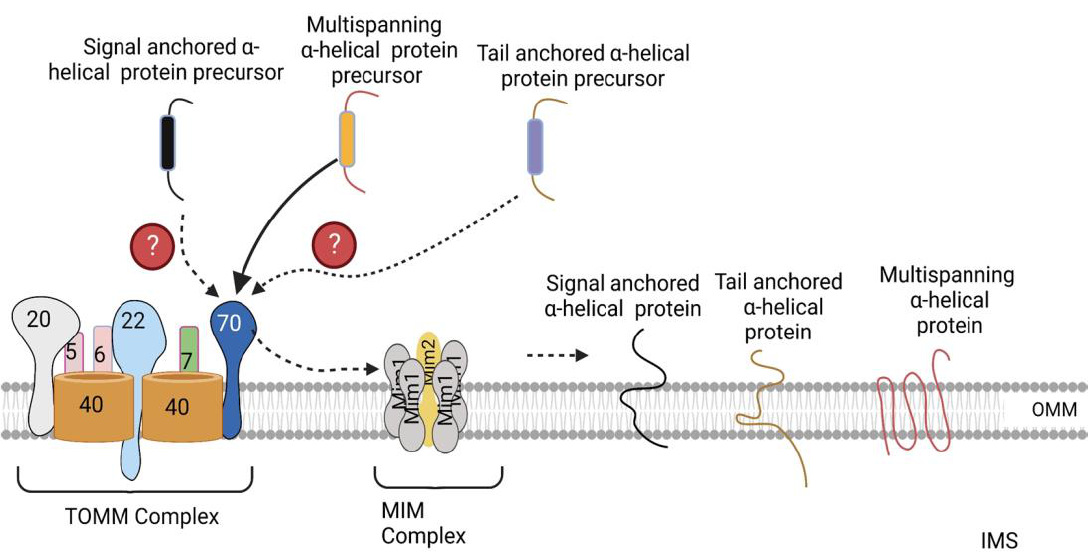
Figure 3. Import of α -helical precursors into the outer mitochondrial membrane. Polytopic proteins are recognized by the TOMM70 receptor, after which TOMM70 binds to them and transfers them to the MIM complex, which inserts them into the OMM. Signal- and tail-anchored α -helical precursors are also inserted into the OMM by the MIM complex. The exact TOMM receptors recognizing these precursors have not been identified yet. OMM, outer mitochondrial membrane. The figure was created with Biorender.com.